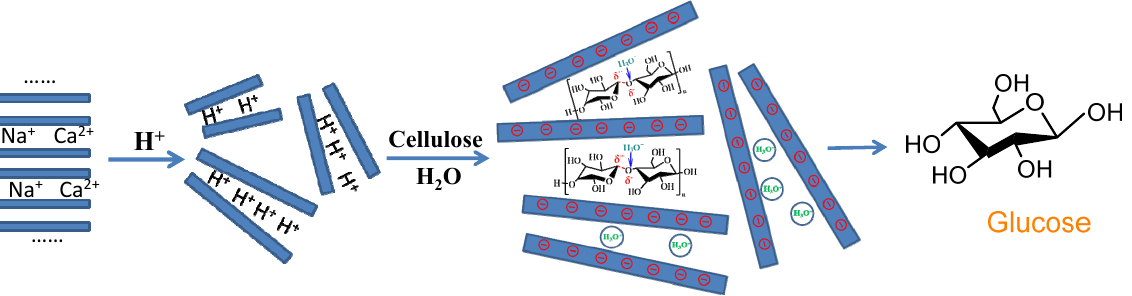
Figure 4. Mechanism of cellulose hydrolysis on acid-activated vermiculite.